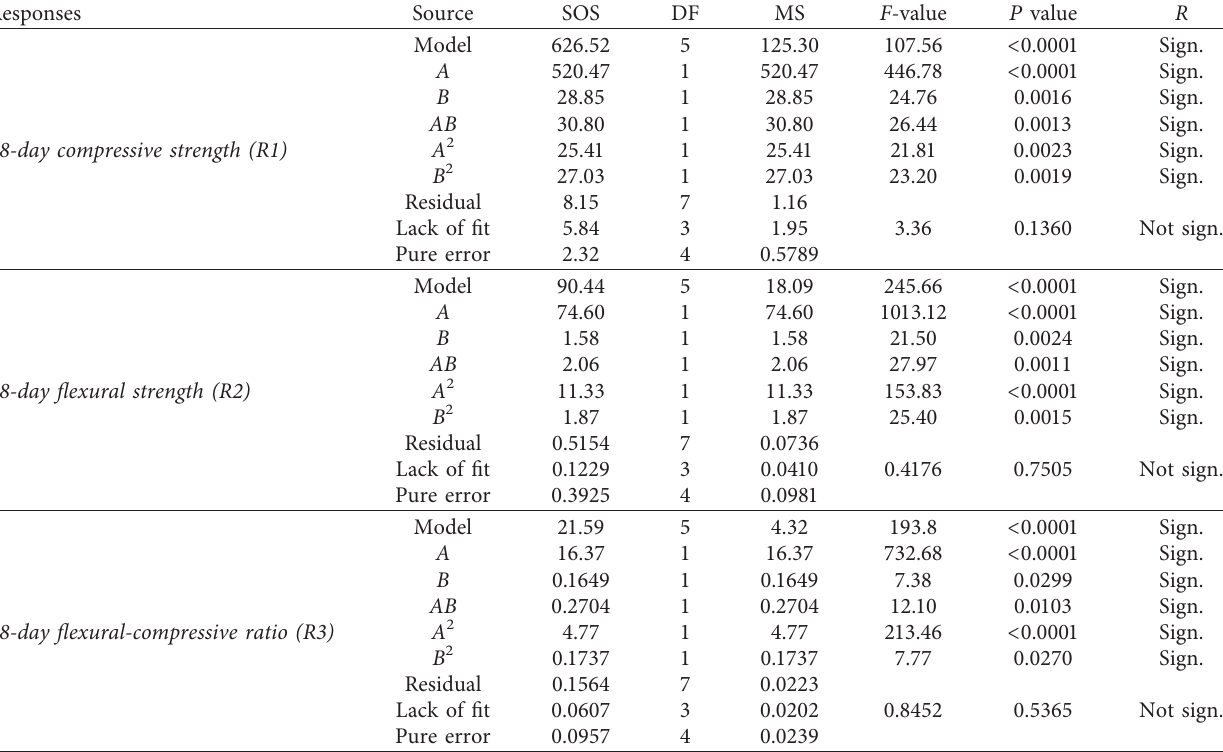
Table 12: ANOVA results for response surface quadratic model parameters.